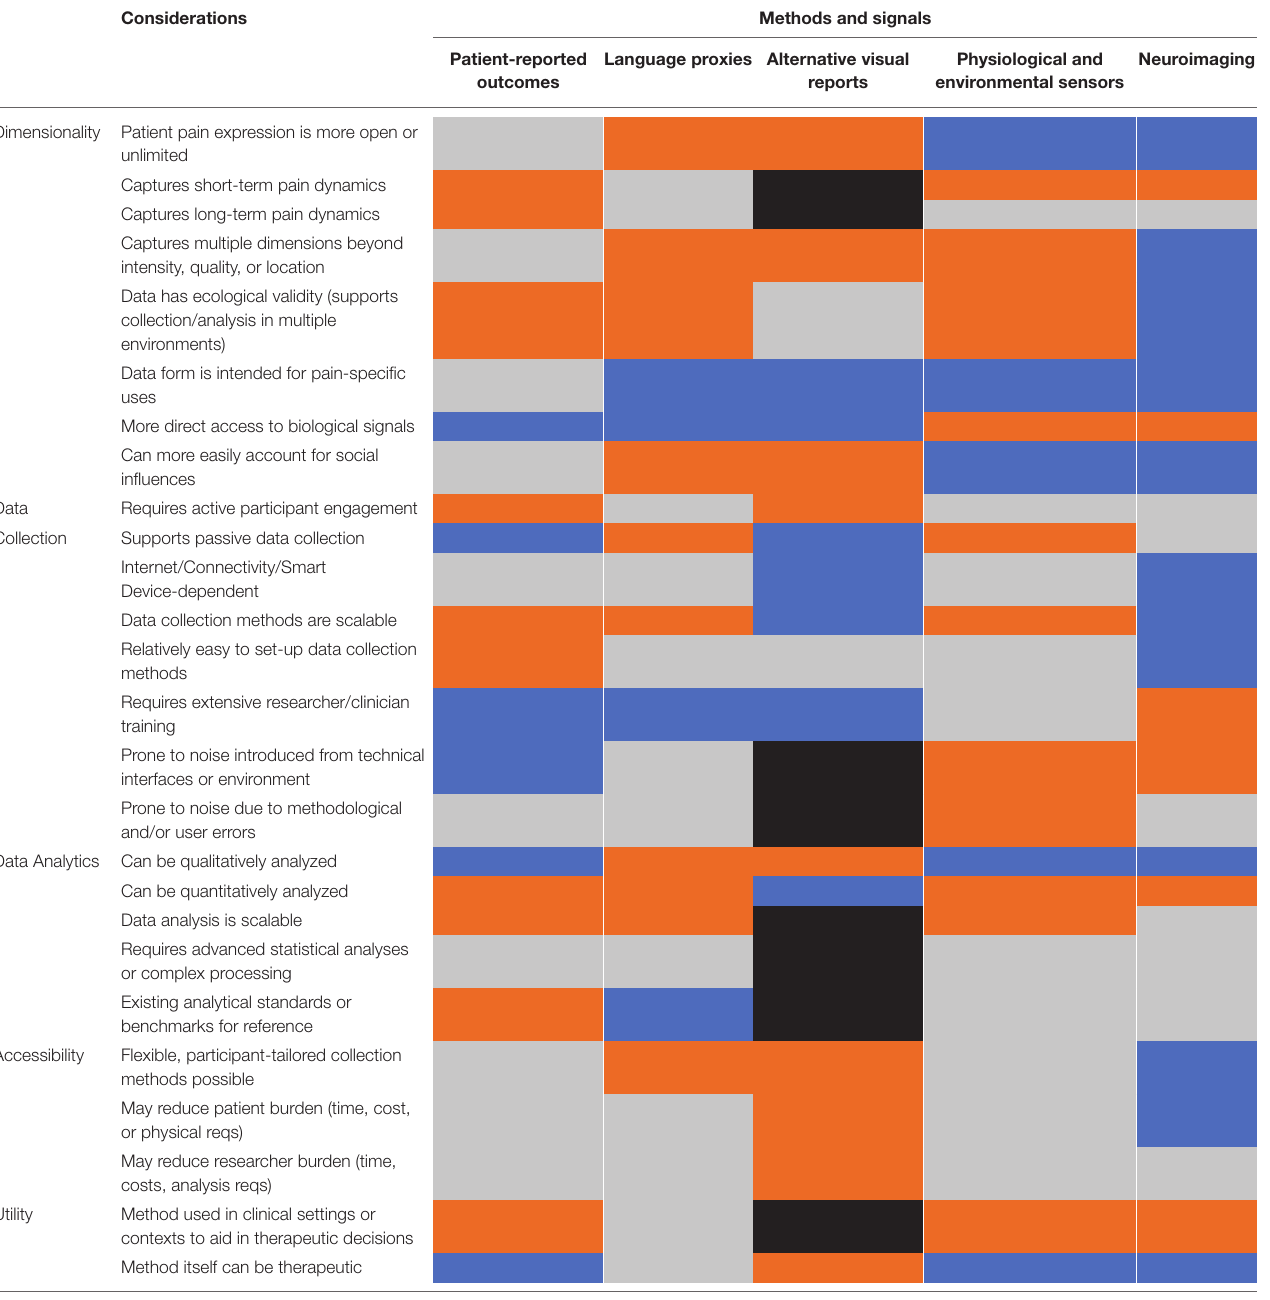
TABLE 1 | Summary of considerations across each reviewed pain methodology.